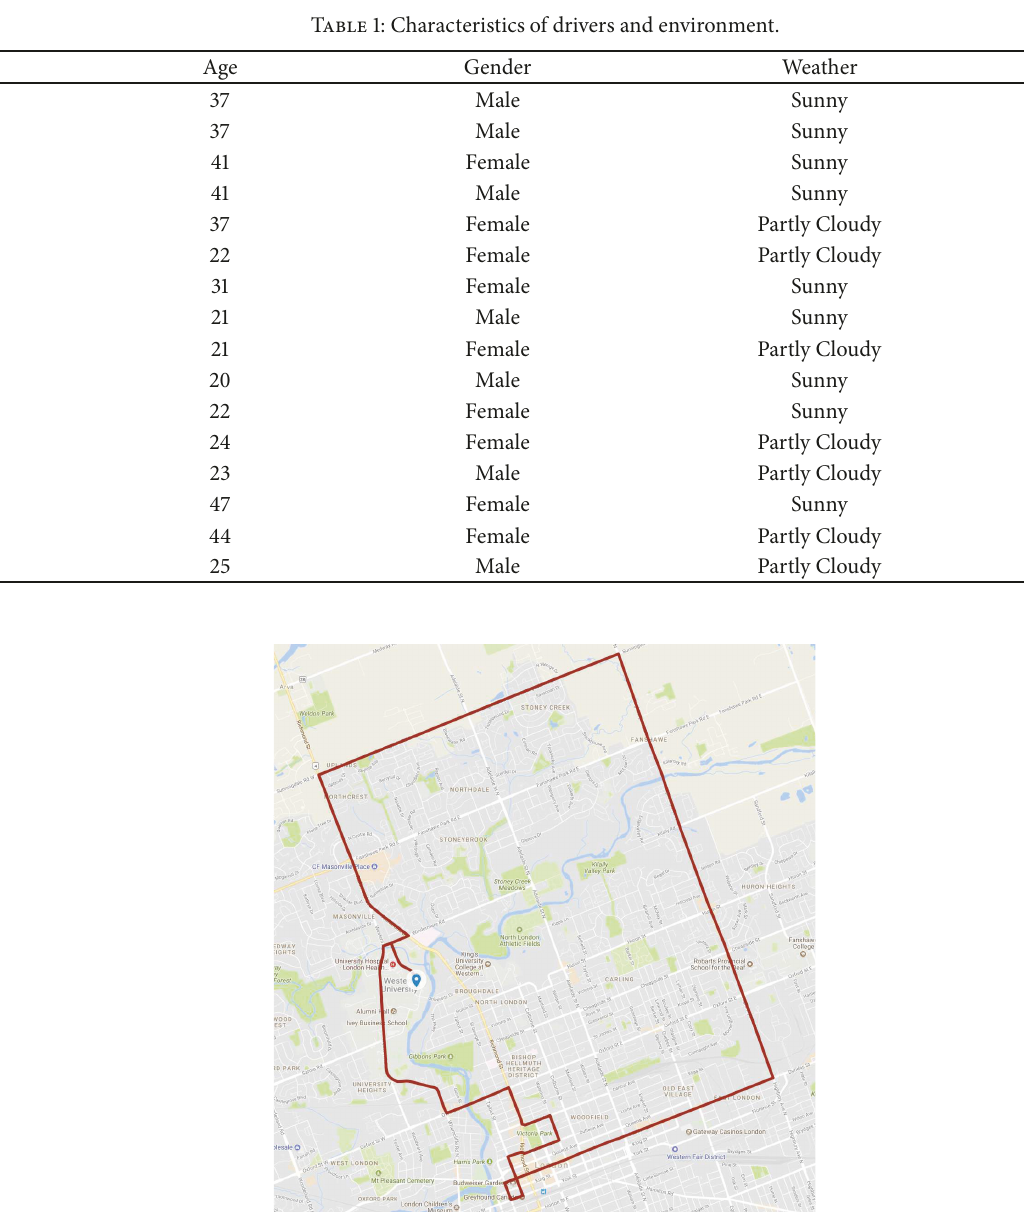
Figure 2: Map of predetermined route for drivers, located in London, Ontario, Canada. The path length is approximately 28.5 kms and includes urban and suburban driving areas. There are 10 right turns and 7 left turns in the